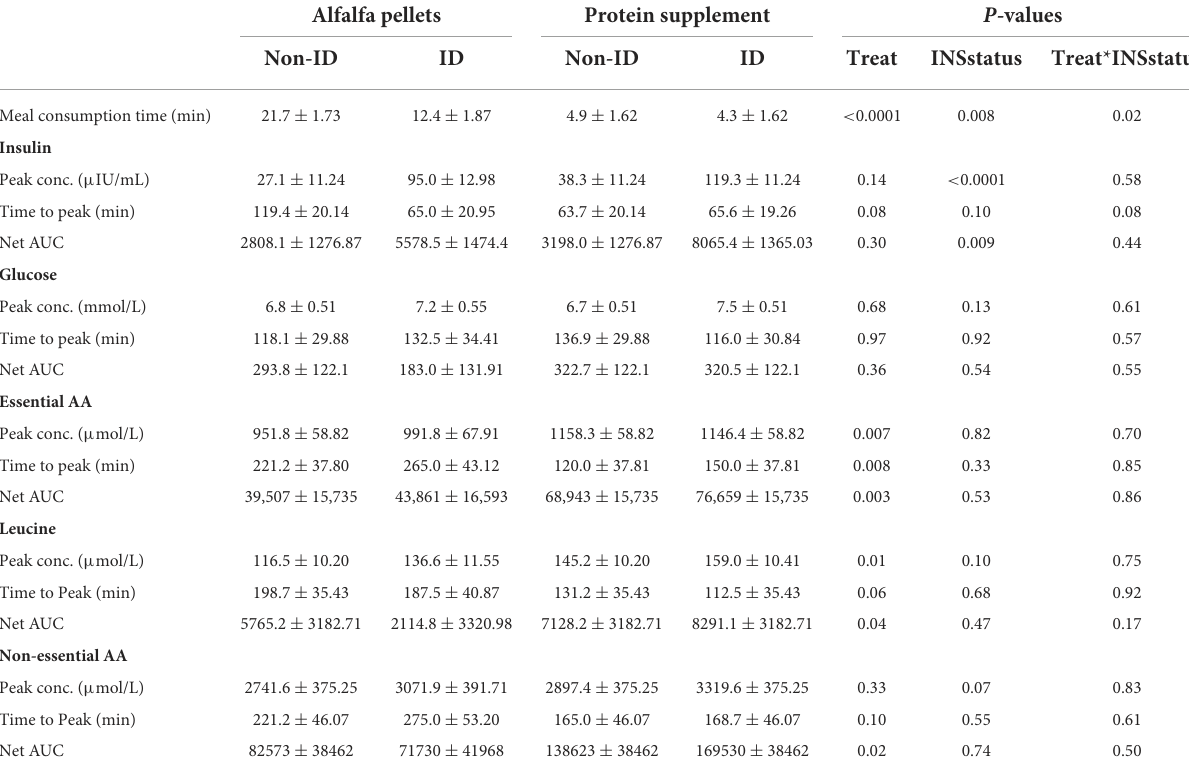
TABLE 5 Effects of protein source and insulin status on plasma insulin, glucose, EAA, leucine and non-EAA concentrations. Alfalfa pellets Protein supplement P -values Non-ID ID Non-ID ID Treat INSstatus Treat *